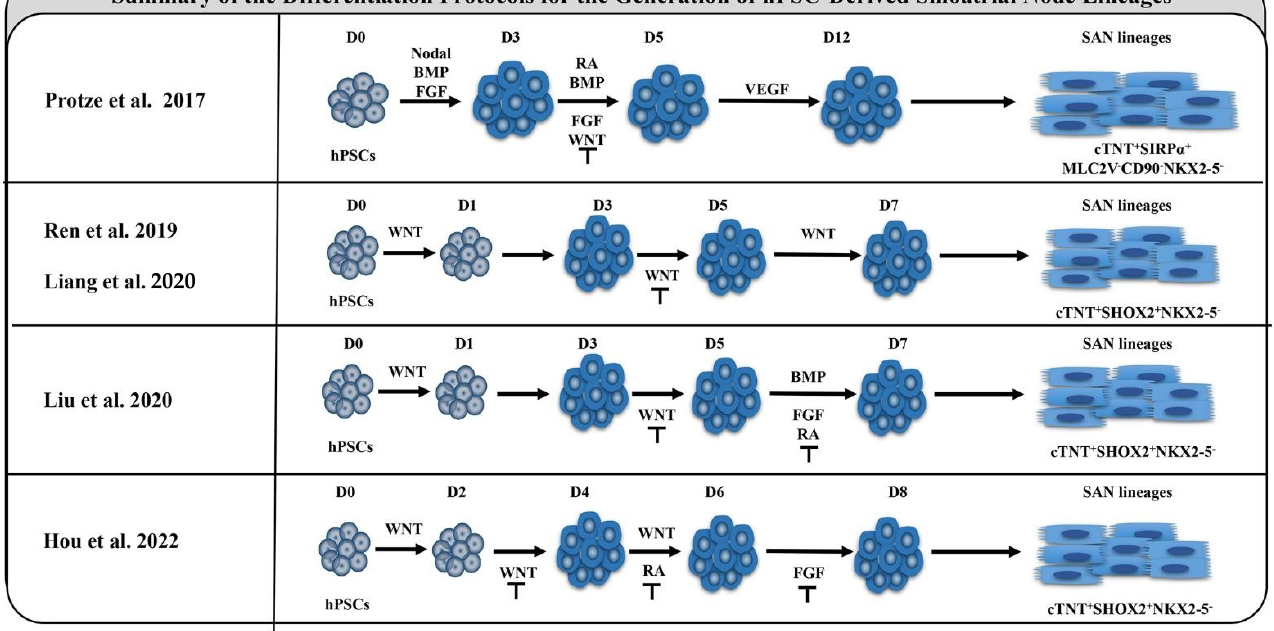
Figure 3. Summary of the differentiation protocols for generating hPSC-derived sinoatrial node lineages. Scheme of the developmentally staged protocol used for sinoatrial node-like pacemaker cells from hPSCs. (Black lines with blunt ends represent the inhibition of the signal pathway; cTNT, cardiomyocyte marker; SIRPA α , pan-cardiomyocyte surface marker; MLC2V, ventricular contractile apparatus protein marker; CD90, mesenchymal marker; NKX2-5, cardiac progenitor marker; SHOX2, conduction cell marker) [68,69,79,82,83].